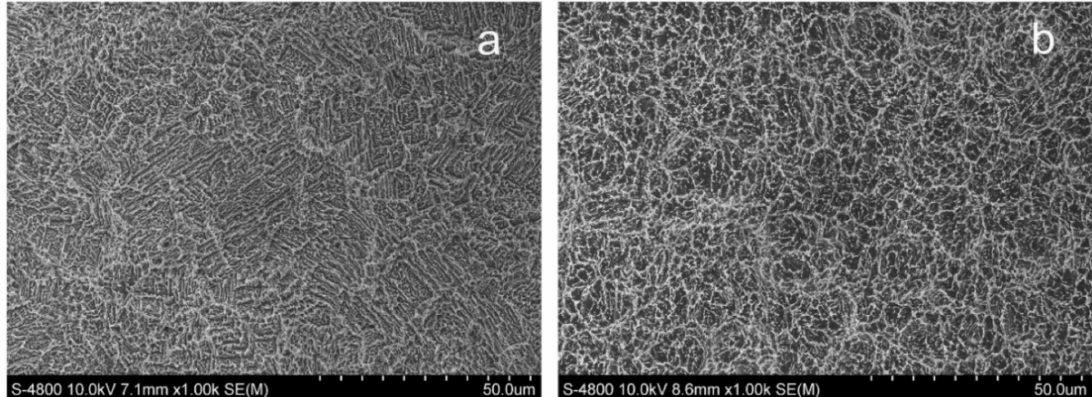
Figure 11. Scanning electron microscopy (SEM) micromorphology of UFG Ti ( a ) and CP Ti ( b ) adapted from [10], with permission from Elsevier,